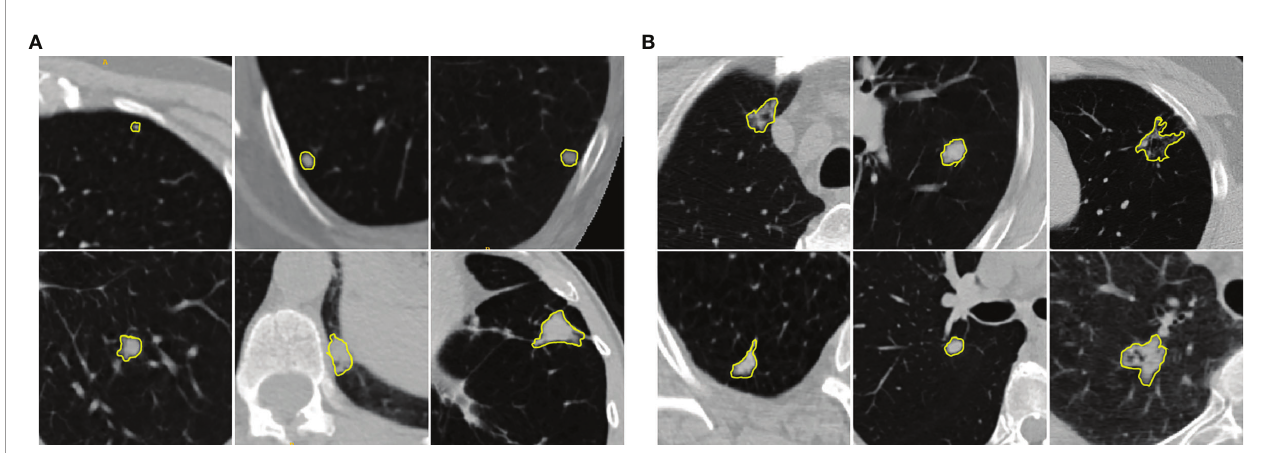
FIGURE 1 | Illustration of (A) benign and (B) malignant pulmonary nodules in chest LDCT scans. The manually identi fi ed nodules are highlighted with yellow contours. The examples show that benign and malignant pulmonary nodules present similar visual characteristics. The cropped patches around the nodules (context images) provide the relative location of the nodules with respect to nearby